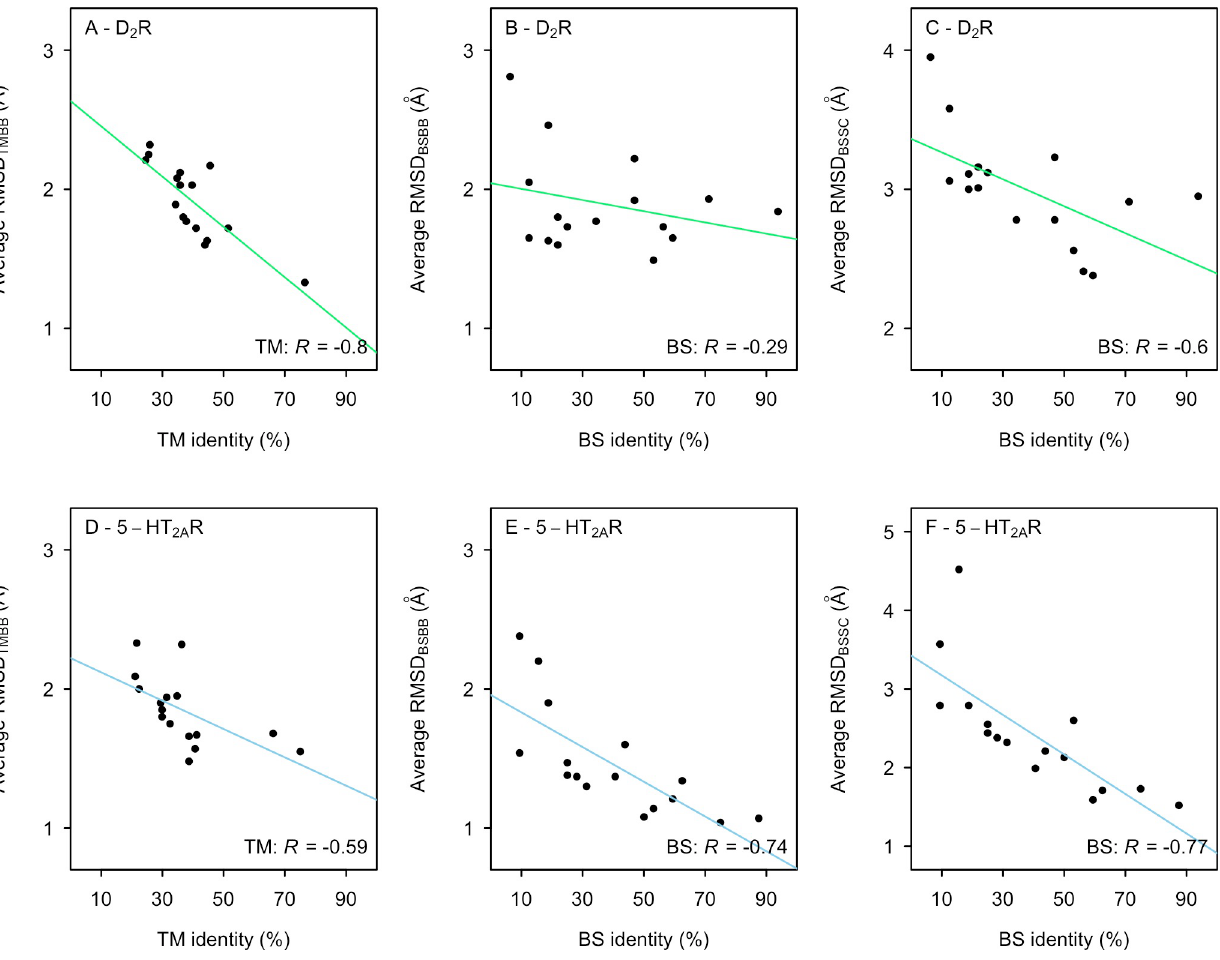
Fig 2. Relation between structural accuracy and sequence identity. The average RMSD TMBB (A and D), RMSD BSBB (B and E), and RMSD BSSC (C and F) to the crystal structures for 50 models of the D 2 R (A-C) and 5-HT 2A R (D-F) based on different templates. The solid line represents a linear regression and R is Pearson’s correlation